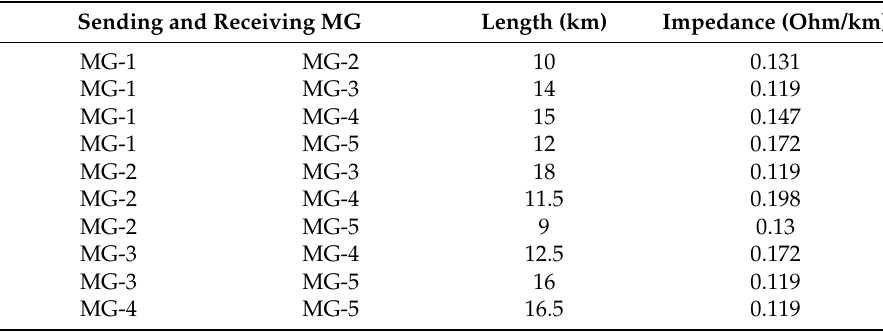
Table 4. Different assumed data of transmission lines between MG-5 and